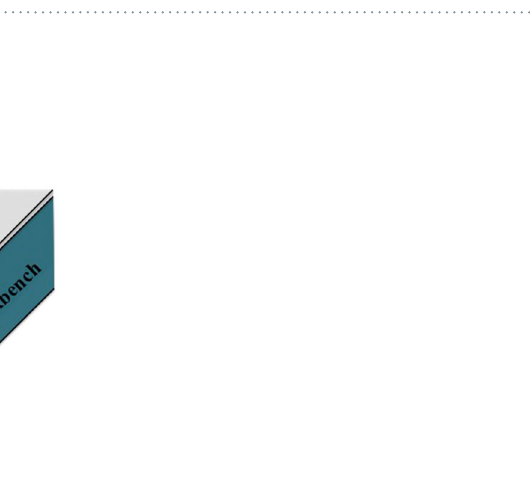
Figure 1. Schematic of the pulsed laser butt welding. A laser beam of controllable power was used to weld metallic glass pieces. The orange arrow indicates the direction of the laser beam is